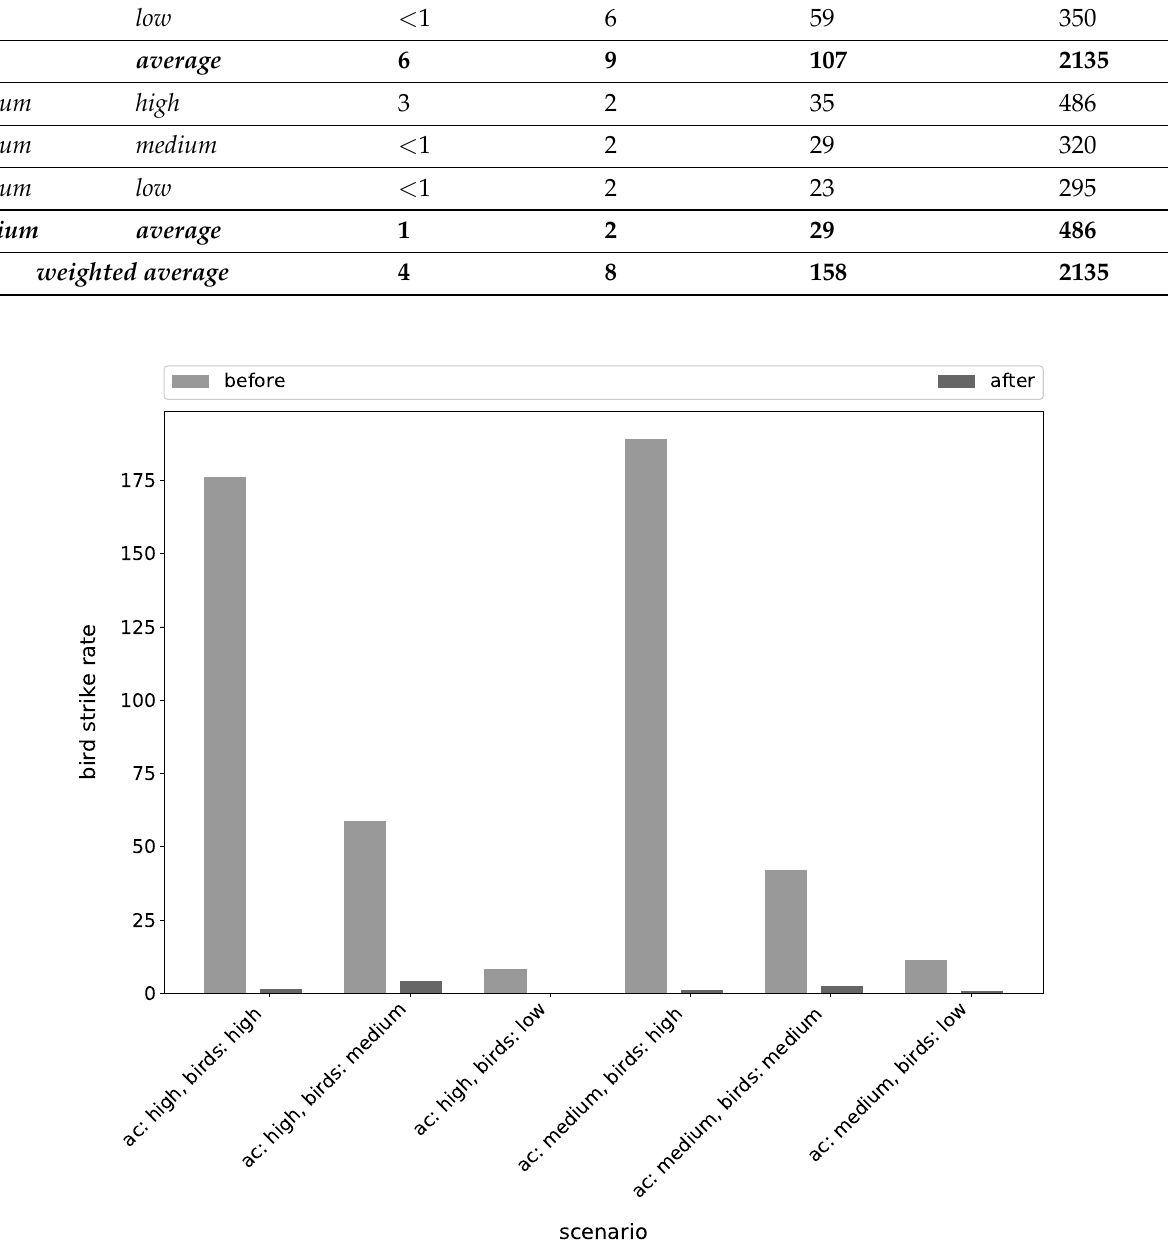
Figure 5. Bird strike rates before and after the intervention of the